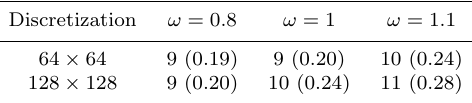
Table 1. Hertzian contact: The number of V(1,1)-cycles by multigrid with GS smoothers to solve C 0 system. The convergence factors of multigrid are given in brackets.